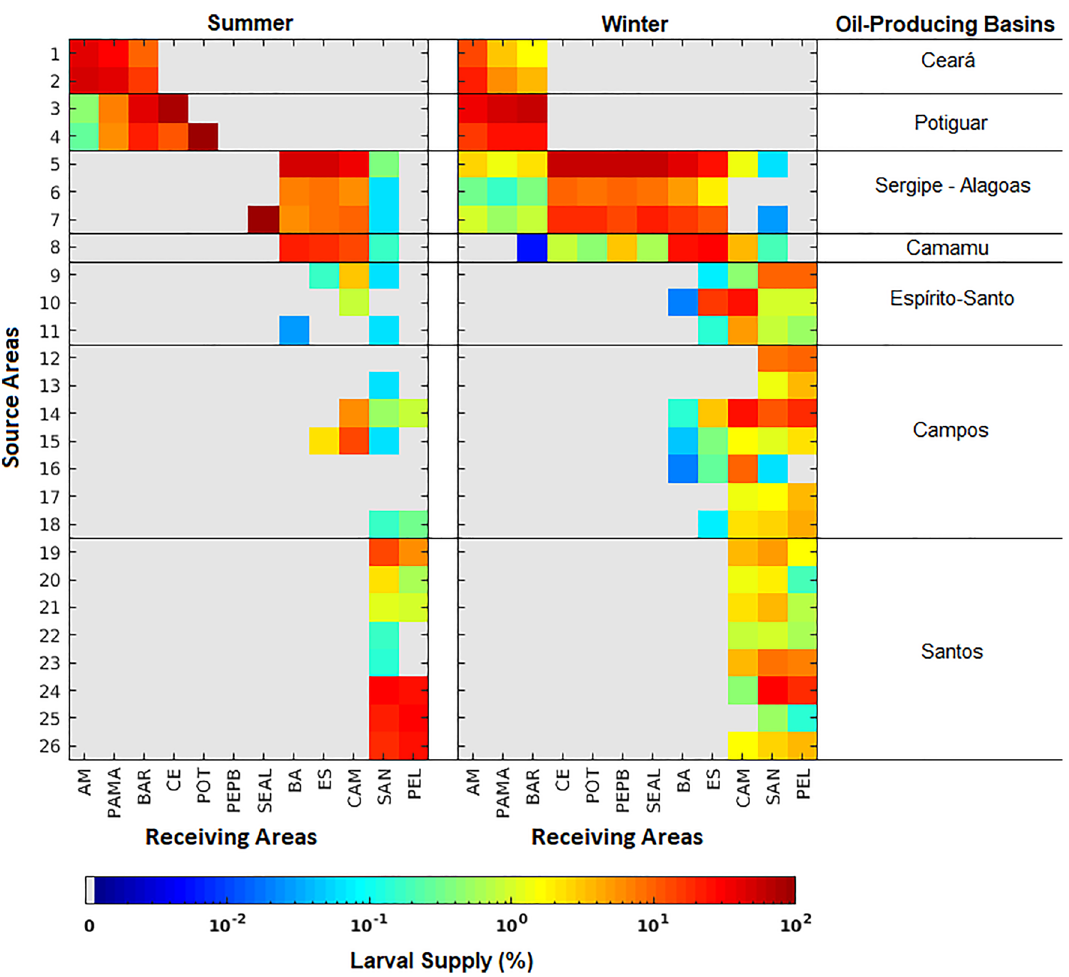
Figure 6. Connectivity matrix representing the relative importance of oil platforms as source areas (y-axis) of sun-coral larvae to the receiving areas (x-axis). Receiving areas are related to its location on the Brazilian coastline and abbreviated as: Amazonas (AM), Pará-Maranhão (PAMA), BAR (Barreirinhas), Ceará (CE), Potiguar (POT), Pernambuco-Paraíba (PEPB), Sergipe-Alagoas (SEAL), Bahia (BA), Espírito Santo (ES), Campos (CAM), Santos (SAN) and Pelotas (PEL). See Fig. 1 for source areas location and Fig. 8 for receiving areas location. Created with Matlab R2018a (http:// www. mathw orks. the Amazon River delta. A wider density kernel occurs between 20 and 30°S, offshore of the 200 m isobath, that includes source areas of Campos and Santos basins, responsible for 54.8% and 15.5% of the total larvae released, respectively. In these basins, oil platforms are located in deeper waters (> 200 m) under the influence of the southward-flowing BC. Although seasonal changes of larvae density are less marked in this eddy-dominated flow region, including the Cabo Frio upwelling (23°S), larvae tend to remain offshore and more concentrated in the summer than during winter. Oil platform location determines their potential as vectors for sun‑coral coastal invasion. Our results indicate the position of oil platforms relative to regional surface flow as a crucial factor for their impor- tance as vectors for sun-coral dispersion on the Brazilian coast. A total of 12 coastal zones were defined as receiving areas or destinations for larvae released from oil platforms. We show in Fig. 6 that the southern basin of Santos with eight release areas impacts only three receiving areas (Campos to the north, Santos itself and Pelotas to the south). In contrast, Camamu with only one release site (and one oil platform) provides larvae for nine other basins (including its own). Here, the strong seasonality of larval supply is also clear with the Sergipe- Alagoas and Camamu platforms providing larvae to all other basins but the southernmost Pelotas (PEL) (total of 11/12 receiving areas) during the winter and only five during the summer. The northern Amazonas (AM), Pará-Maranhão (PAMA), BAR (Barreirinhas), Ceará (CE), and Potiguar (POT) receiving areas did not have any larvae from the Sergipe-Alagoas Basin during the summer, and Pernambuco-Paraíba (PEPB) received larvae only during the winter. The most connected basins are Campos (CAM) and Santos (SAN), which received larvae from as far north as the Sergipe-Alagoas basin during both seasons. Despite being located at the southernmost region of the Brazilian coast, the receiving area PEL is supplied with larvae originating mainly from the Campos